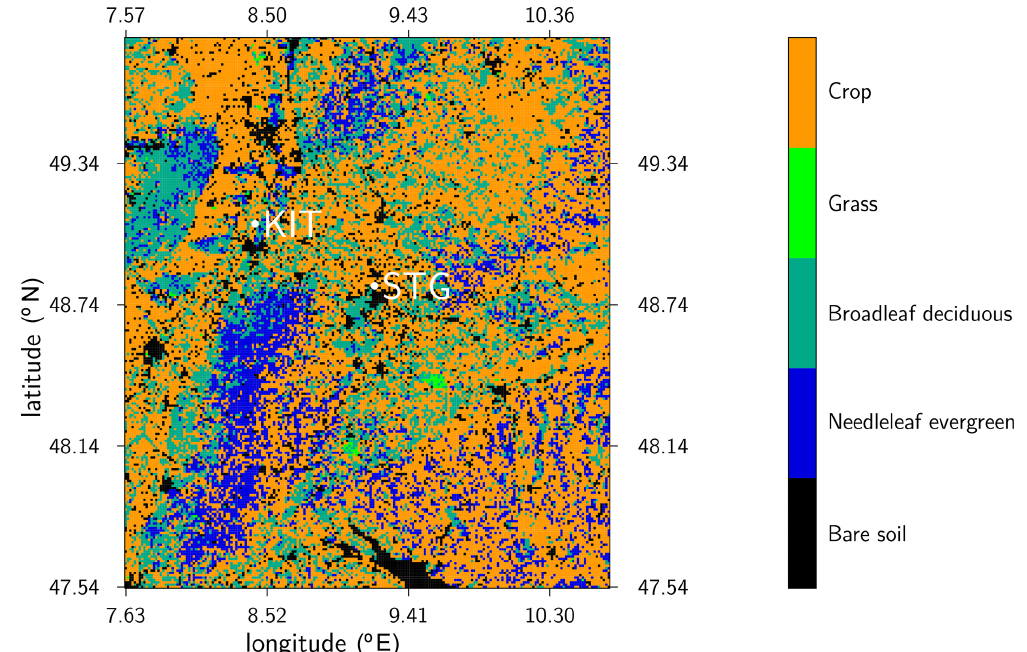
Figure 2. Land cover in the simulated domain covering the entire Neckar catchment and bounding areas. KIT: Karlsruhe Institute of Tech- nology (location of meteorological tower observations), STG: Stuttgart (location of radiosonde observations).